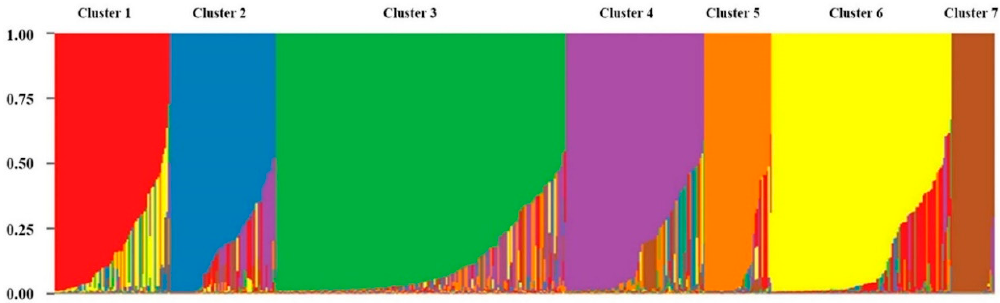
Figure 4. Structure plot presenting seven clusters of rice germplasm collection. The y -axis indicates the estimated membership coe ffi cients for each individual. Each variety’s genome is represented by a single vertical line, which is partitioned into colored segments in proportion to the estimated membership in the seven